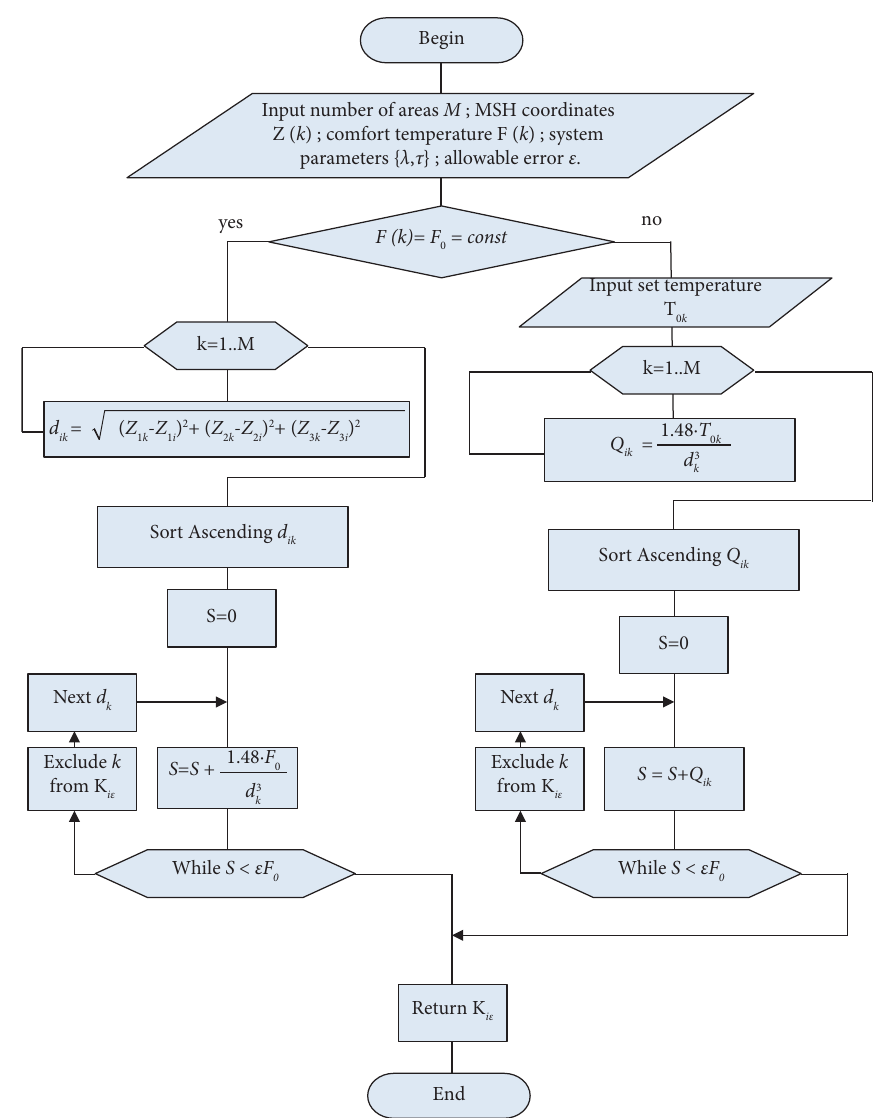
Figure 3: Algorithm for clustering a multiarea premise without